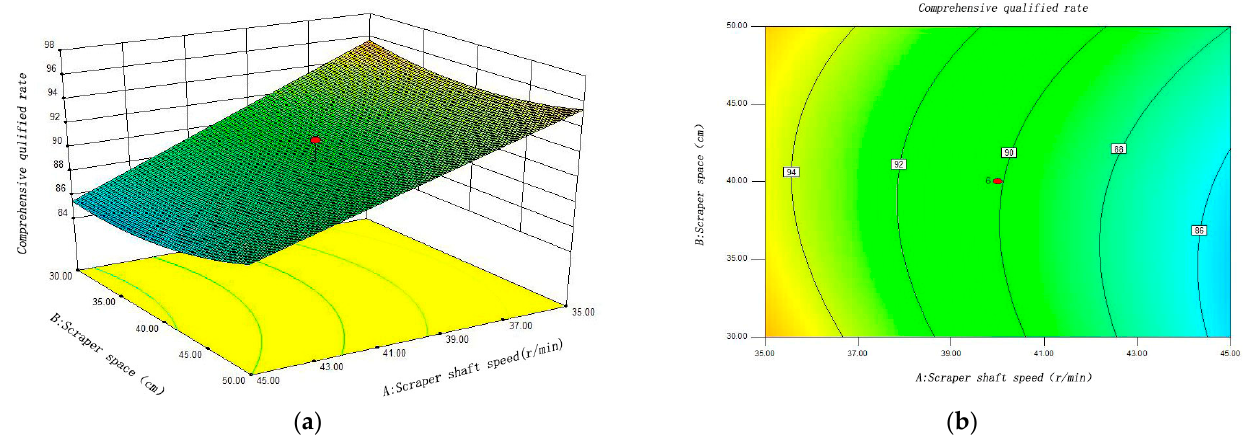
Figure 7. A × B interaction effect ( a ) and contour line ( b